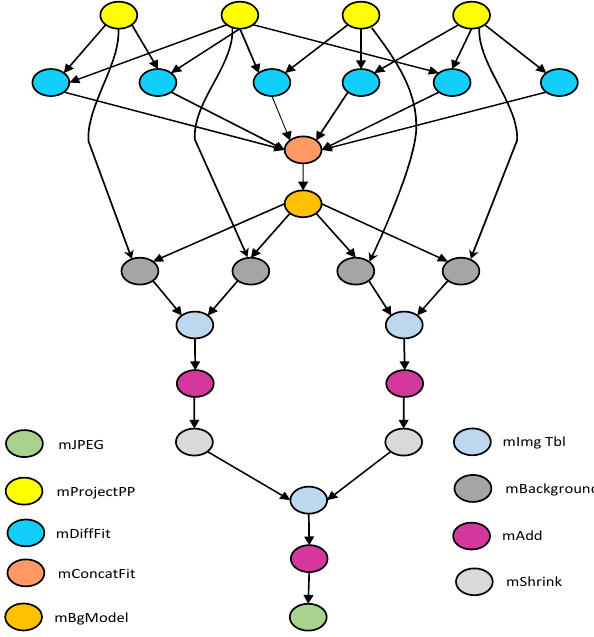
Figure 2. Montage workflow.